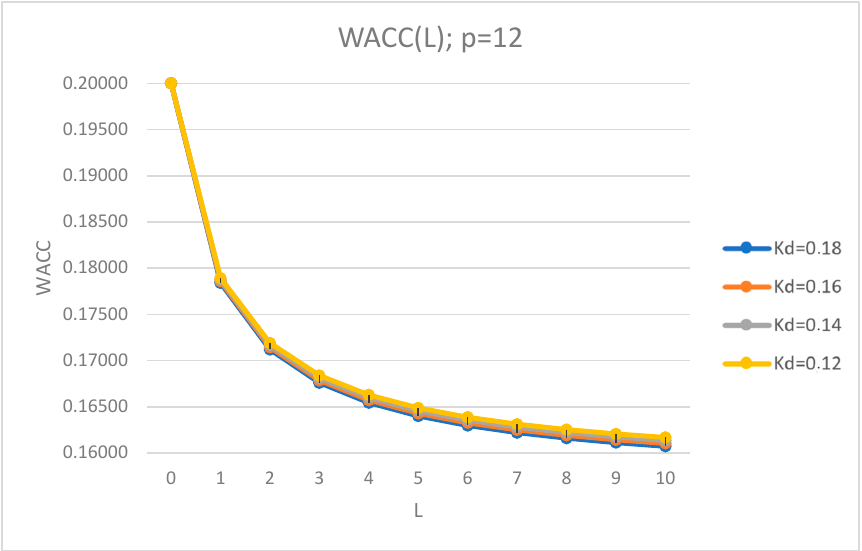
Figure 4. Dependence of the weighted average cost of capital (WACC) on leverage level L at different debt cost k d (12%; 14%; 16%; 18%) and fixed frequency of payments of tax on profit p = 12. Let us show these dependencies in a larger scale.